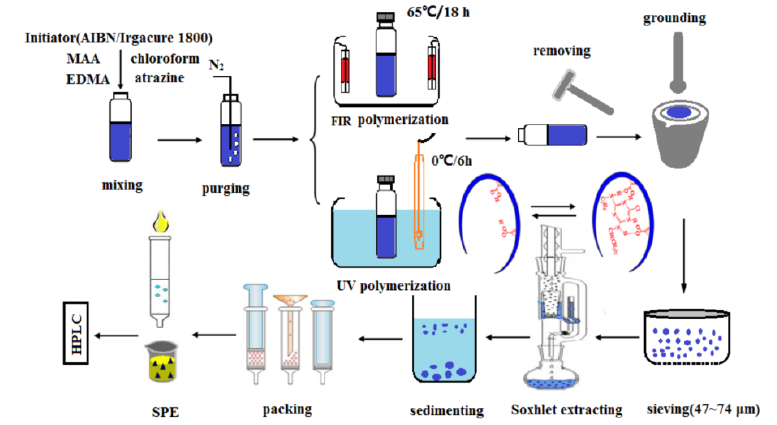
Figure 8. Schematic representative of preparation of atrazine imprinted polymers for